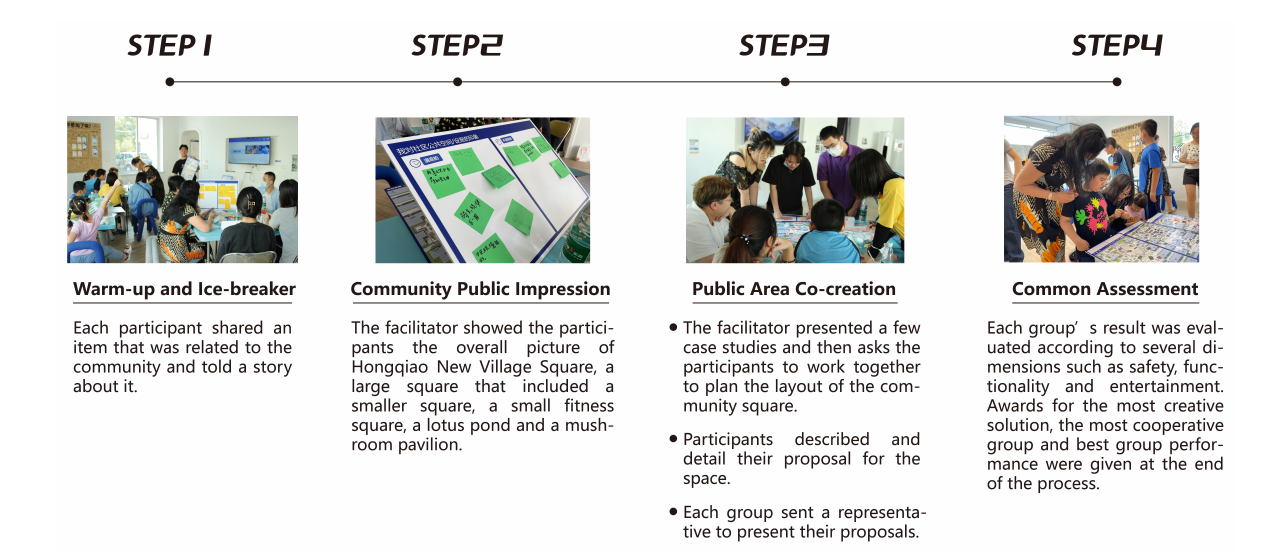
4Figure 4. Co-creation workshop Figure